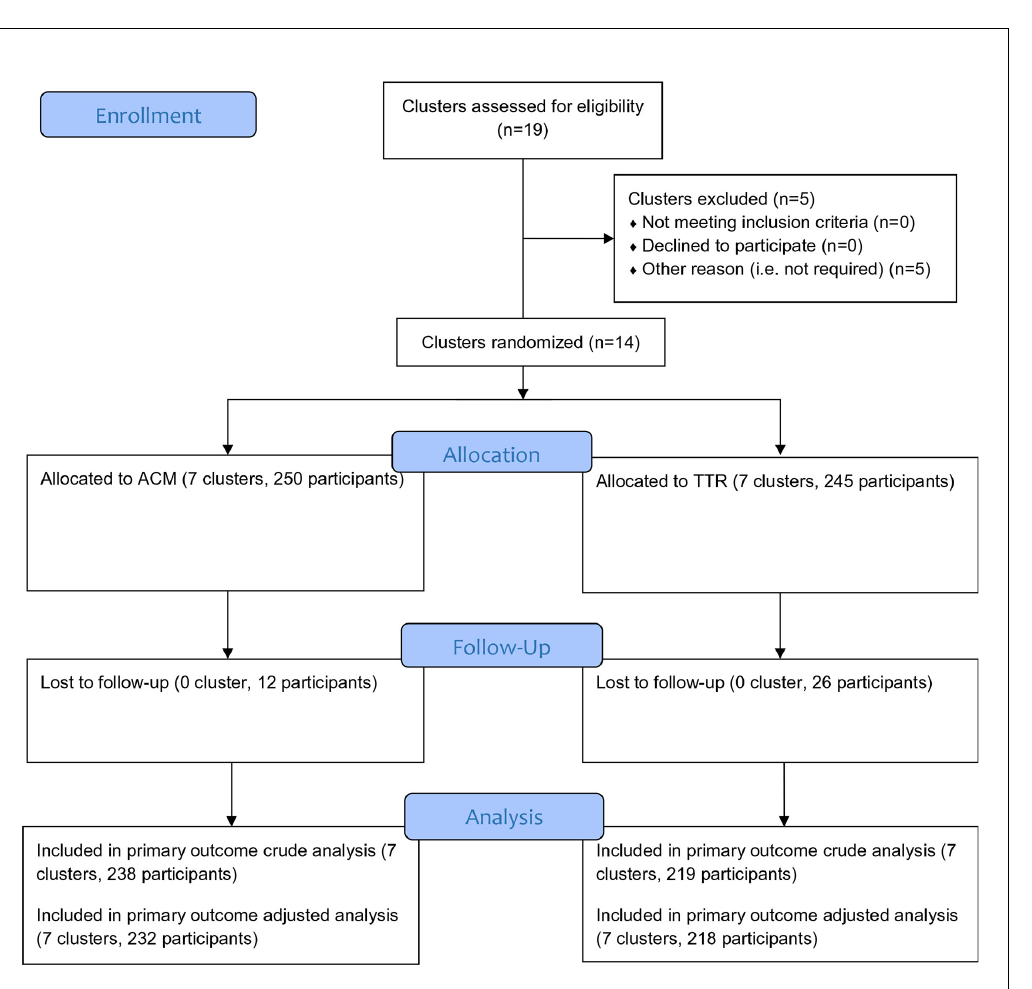
Figure 2. CONSORT trial flow chart ACM = additional case management. TTR = testing, treating, and